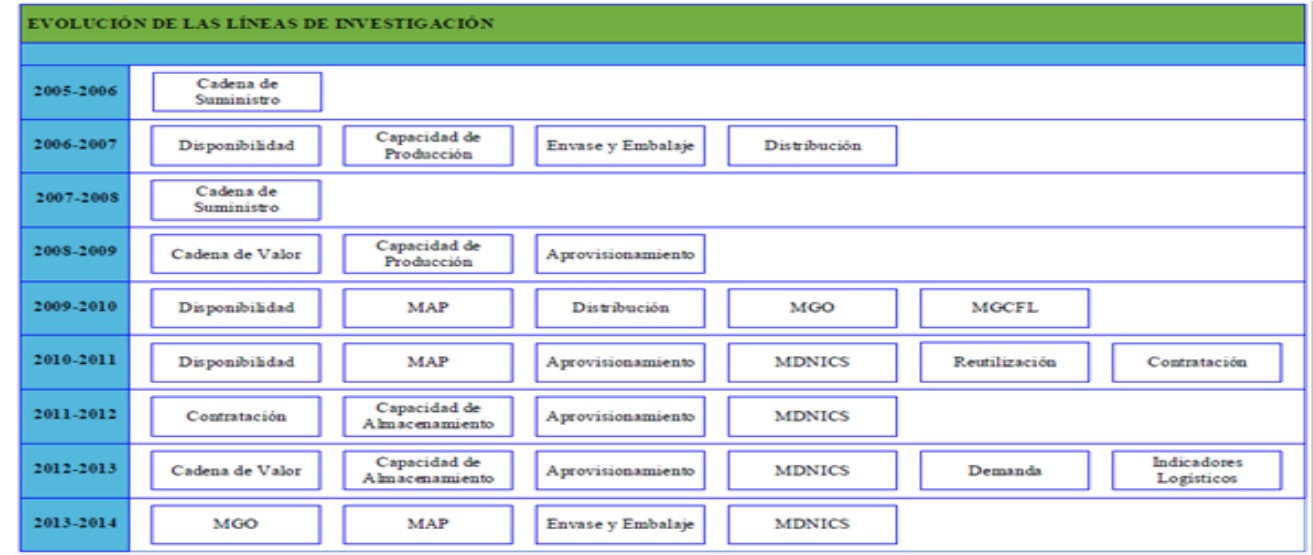
Figura 5: Evolución de las líneas de investigación desarrollas por ECASOL y LOGESPRO de manera conjunta . Fuente: Los autores,